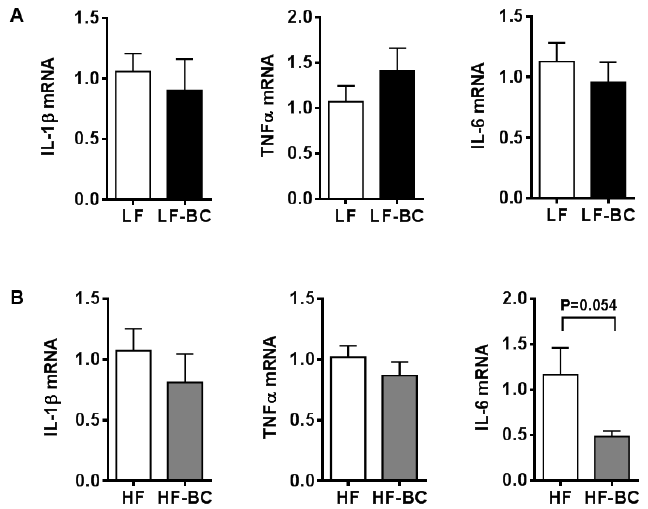
Figure 5. Expression of pro-inflammatory genes in mouse bone marrow-derived macrophages (BMDM) treated with serum from mice fed blackcurrant. ( A ) Mouse serum was collected during the feeding cycle from mice fed a low fat control (LF) or a LF with blackcurrant (LF-BC, LF supplemented with 6% of freeze-dried whole blackcurrant powder by weight) for one week ( n = 7 per group). BMDM were treated with 15% serum for 18 h for gene analysis. ( B ) Mouse serum was collected during the feeding cycle from mice fed an obesogenic high fat/high sucrose control (HF) or a HF with 6% blackcurrant (HF-BC) for 22 – 23 week ( n = 14 and 15, respectively). Serum samples from three mice were pooled and BMDM were treated with 15% the serum for 18 h. Data are shown as mean ± SEM.